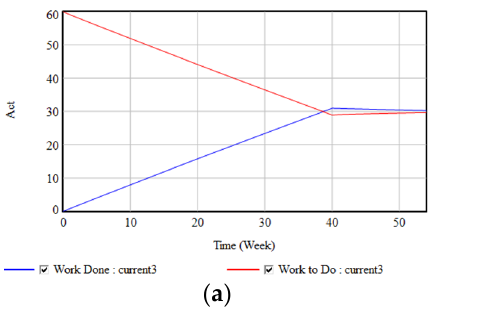
Figure 2. General Vensima simulation model for success criterion C 1 : the number of well-conducted interviews according to the information available within the project realization time.